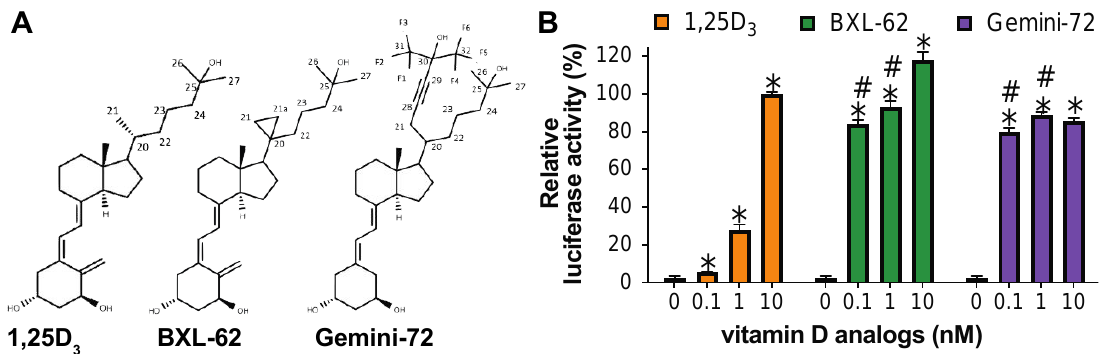
Figure 1. Structure and transcriptional activity of the C-20 modified analogs BXL-62 and Gemini-72. ( A ) Chemical structures of 1,25D 3 and analogs; ( B ) Fold change of the relative activity of a reporter gene under the control of the promoter region of CYP24A1 in COS cells transiently transfected with hVDR, and treated for 24 h, as indicated. The results are shown as % of the relative activity determined in cells overexpressing WT VDR and treated with 10 nM of 1,25D 3 . n = 3 biological replicates/condition. * p < 0.05 vs. vehicle. # p < 0.05 vs. a similar dose of 1,25D 3